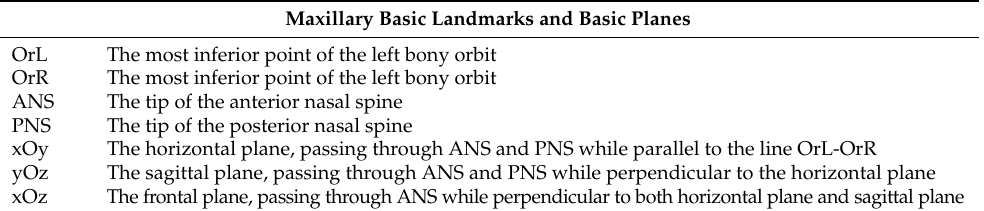
Table 1. Maxillary basic landmarks and planes of the maxilla-based coordinate system.